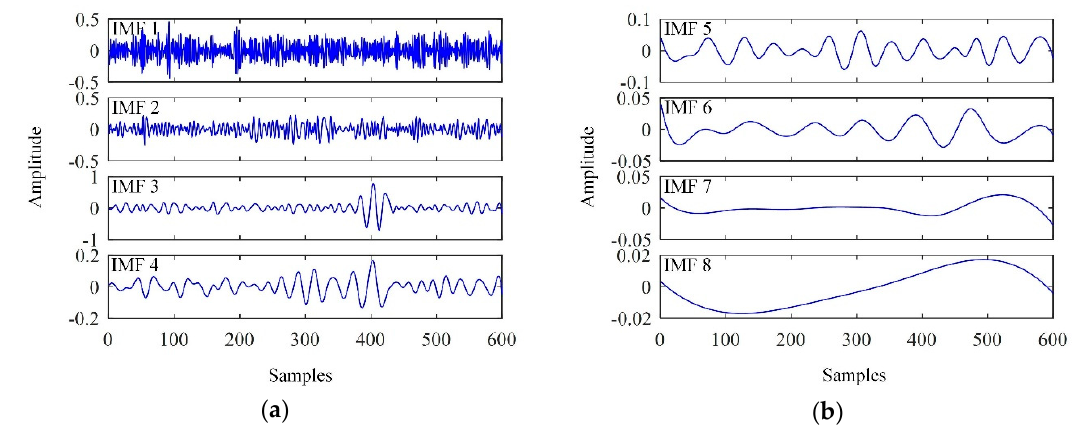
Figure 2. Intrinsic mode functions (IMFs) extracted. ( a ) IMF 1 ~ IMF 4; ( b ) IMF 5 ~ IMF 8.